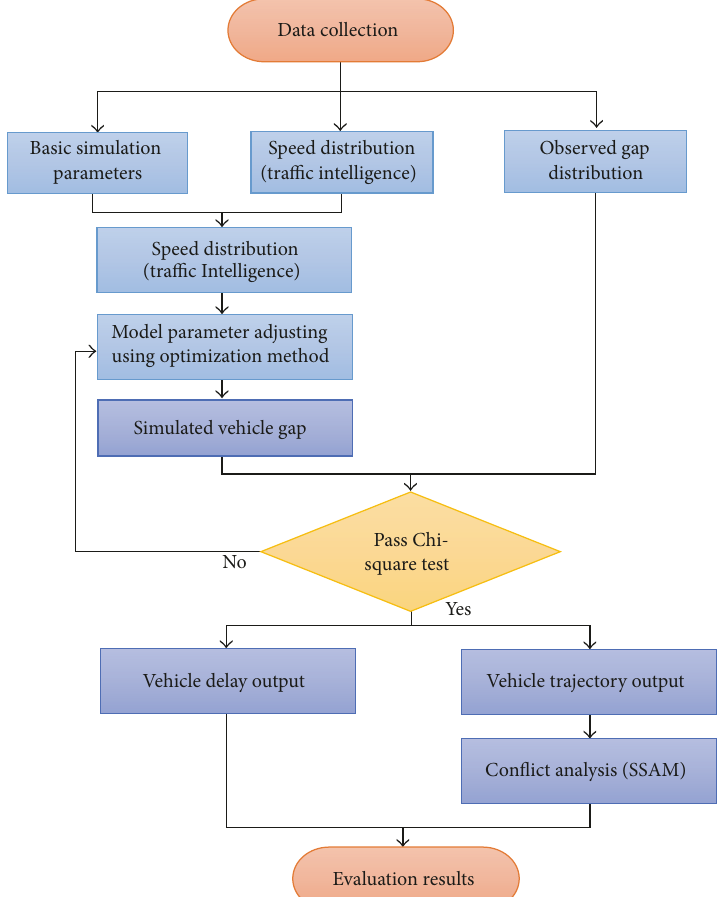
Figure 4: Framework of evaluation procedure.